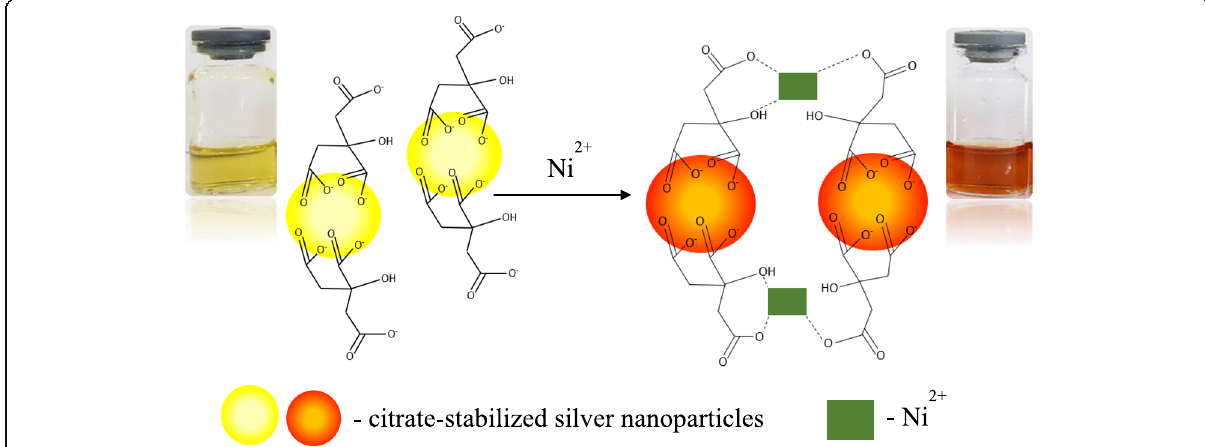
Fig. 7 Proposed mechanism of aggregation of citrate-stabilized silver nanoparticles through Ni 2+ binding with citrate ions